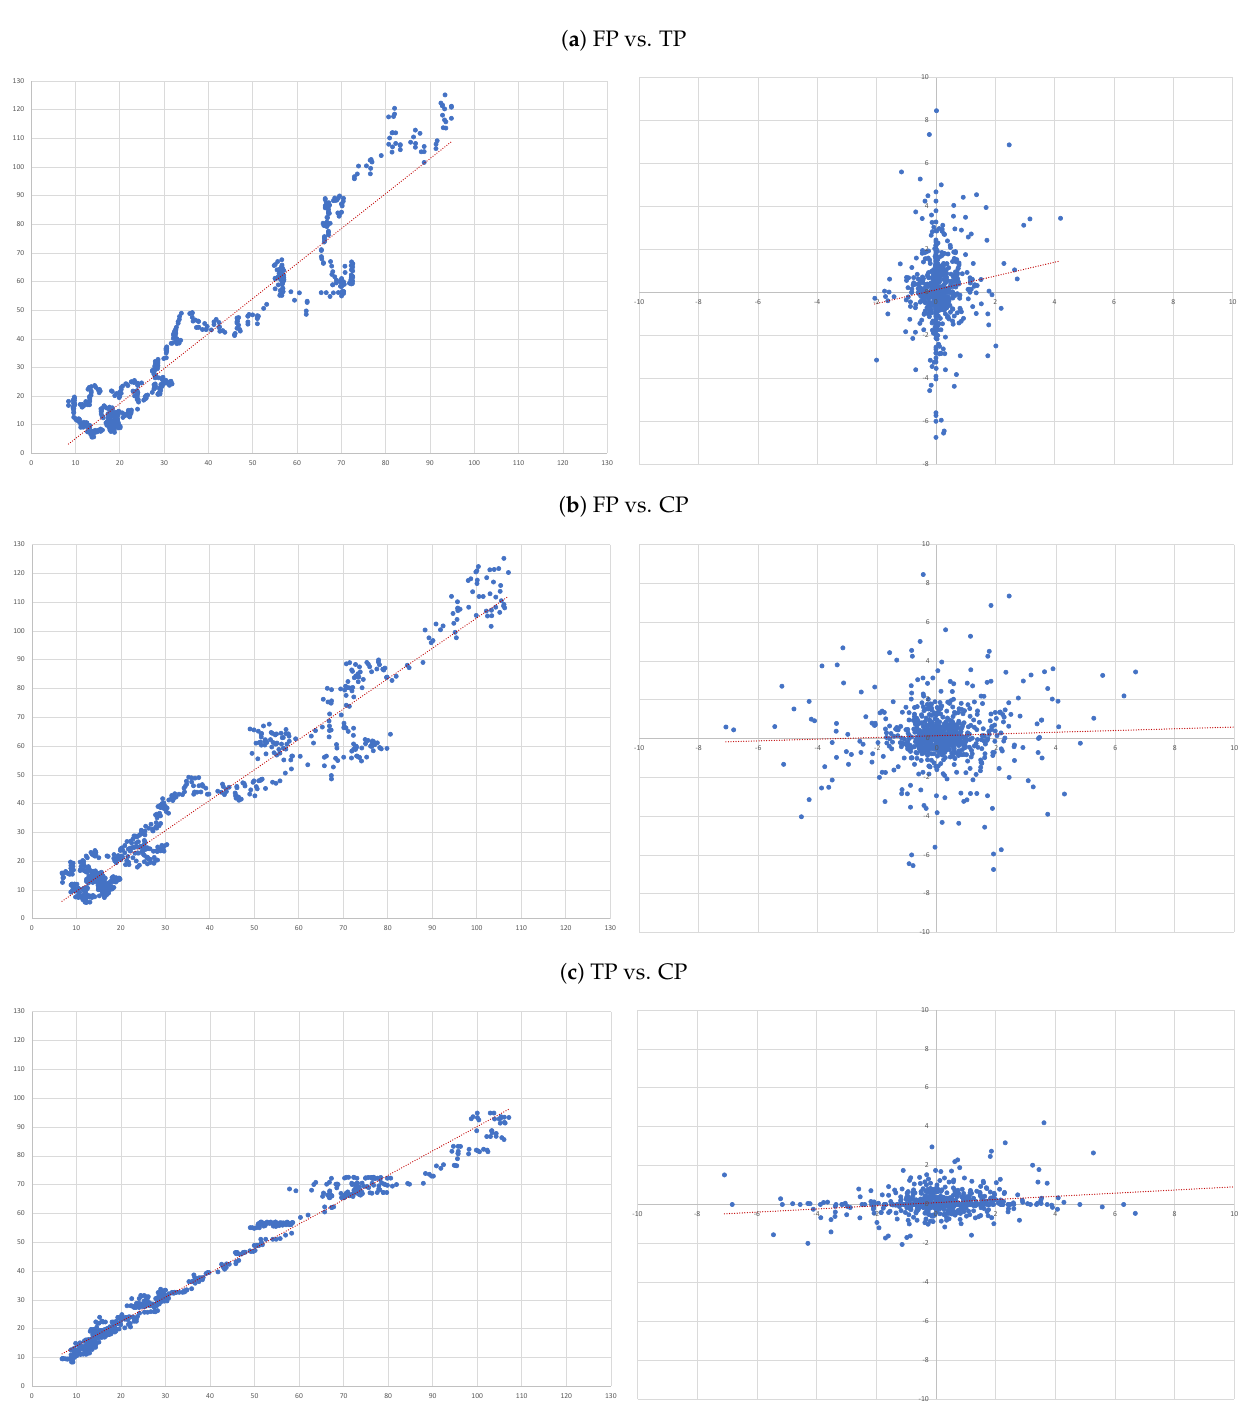
Figure A7. Safran. Individual time series regressions using three price series on Safran: future prices (FP), target prices (TP), and capitalised prices (CP) forecasts. On the left-hand-side are images of level regressions and on the right-hand-side are regressions in